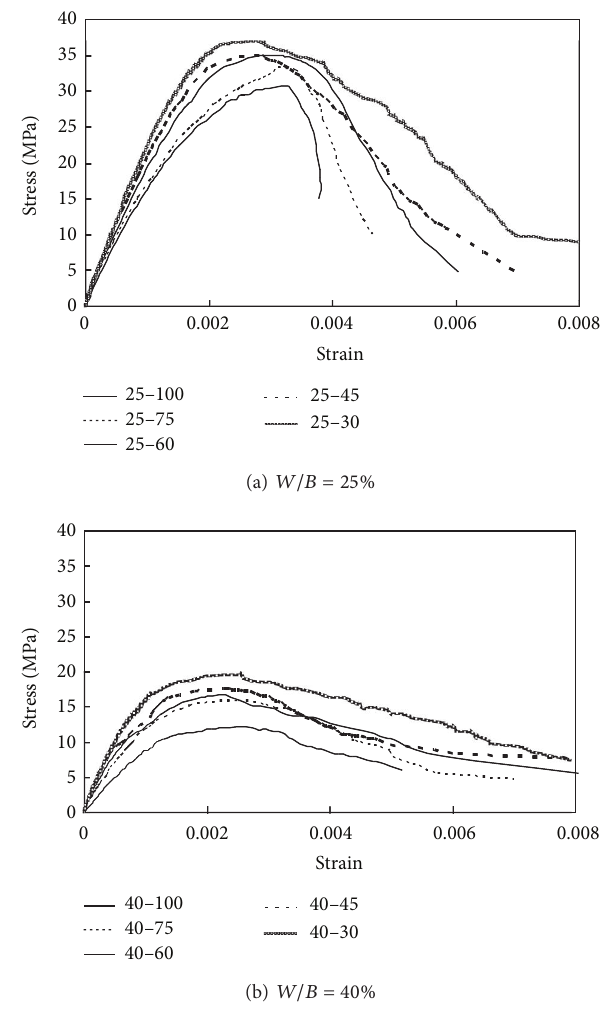
Figure 4: Stress-strain curves measured for Ca(OH) 2 -activated Hwangtoh concrete.